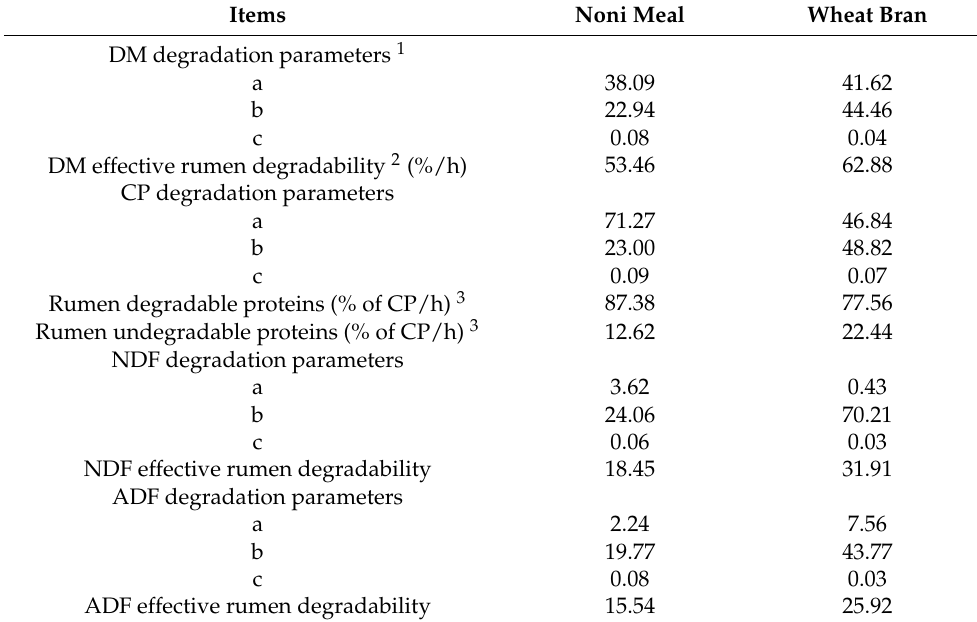
Table 6. Rumen in situ dry matter (DM), crude protein (CP), neutral detergent fiber (NDF) and acid detergent fiber (ADF) degradation parameters and effective rumen degradability of noni meal and wheat bran. Items Noni Meal Wheat Bran DM degradation parameters 1 a